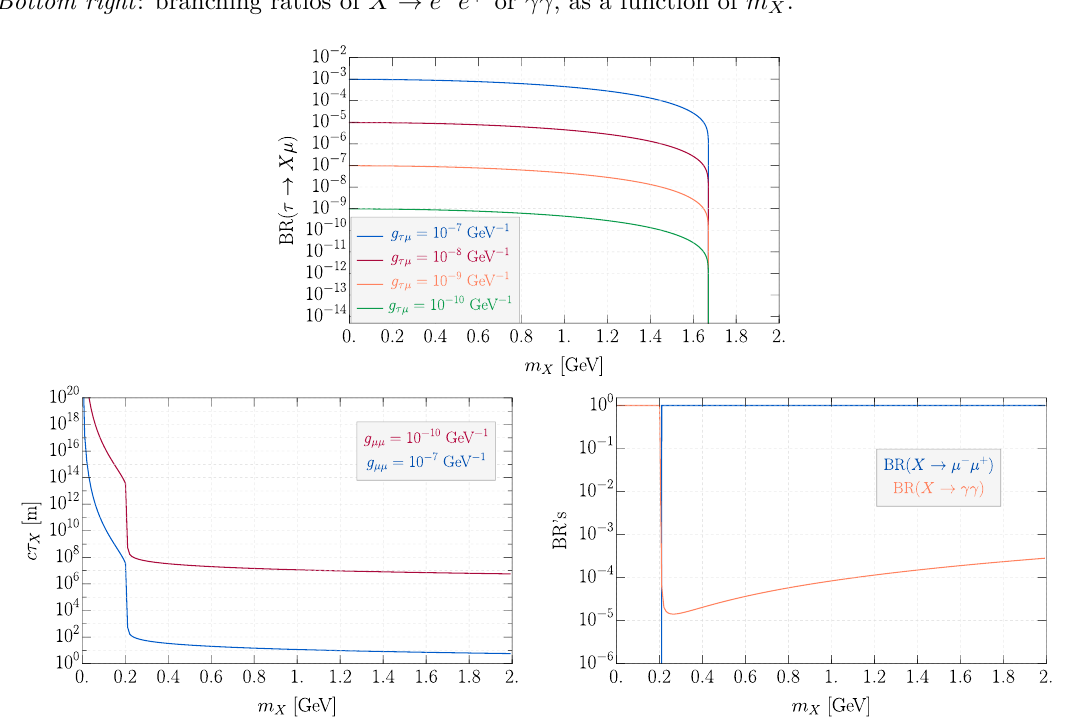
Figure 2 . Scenario 2. The same format as in figure 1, replacing e by µ